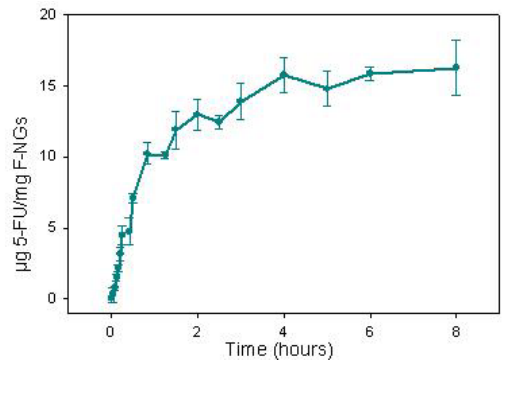
Figure 2. Cumulative amount of 5-fluorouracil (5-FU) released from low load 5-FU-loaded